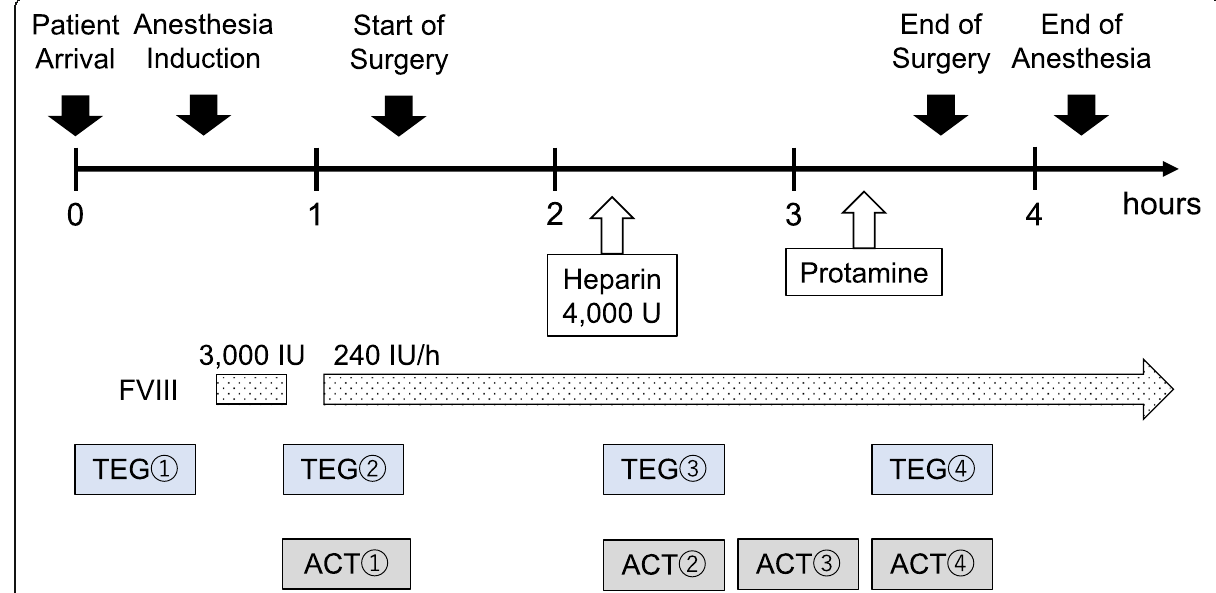
Fig. 1 Anesthesia course and coagulation monitoring. TEG was performed at 4 points. ACT was performed simultaneously with TEG and 1 more point during heparinization. ACT, activated clotting time; FVIII, factor VIII; TEG,